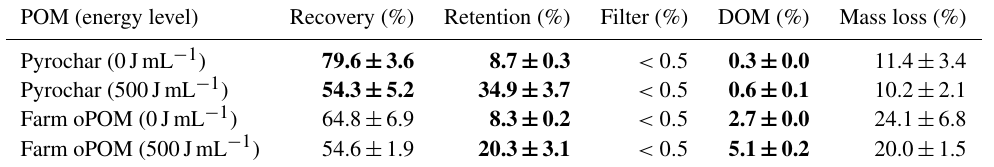
Table 3. Mass balance that indicates the fate of OM fractions during the ultrasonication/density fractionation treatment. Bold numbers indicate differences with p < 0 . 05 after t test between the 0 and 500JmL − 1 variant ( n =